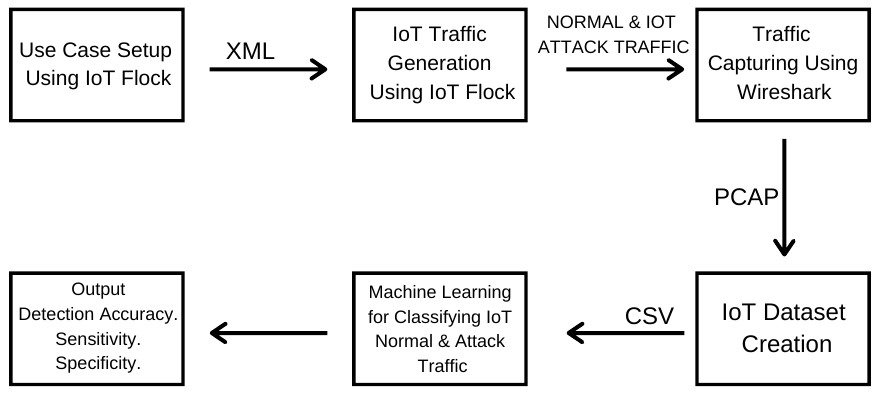
Figure 1. Framework for research in IoT health care